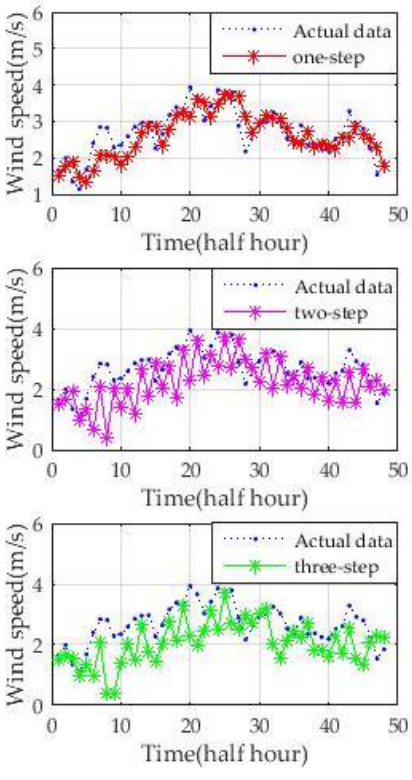
Energies 2016 , 9 , 989